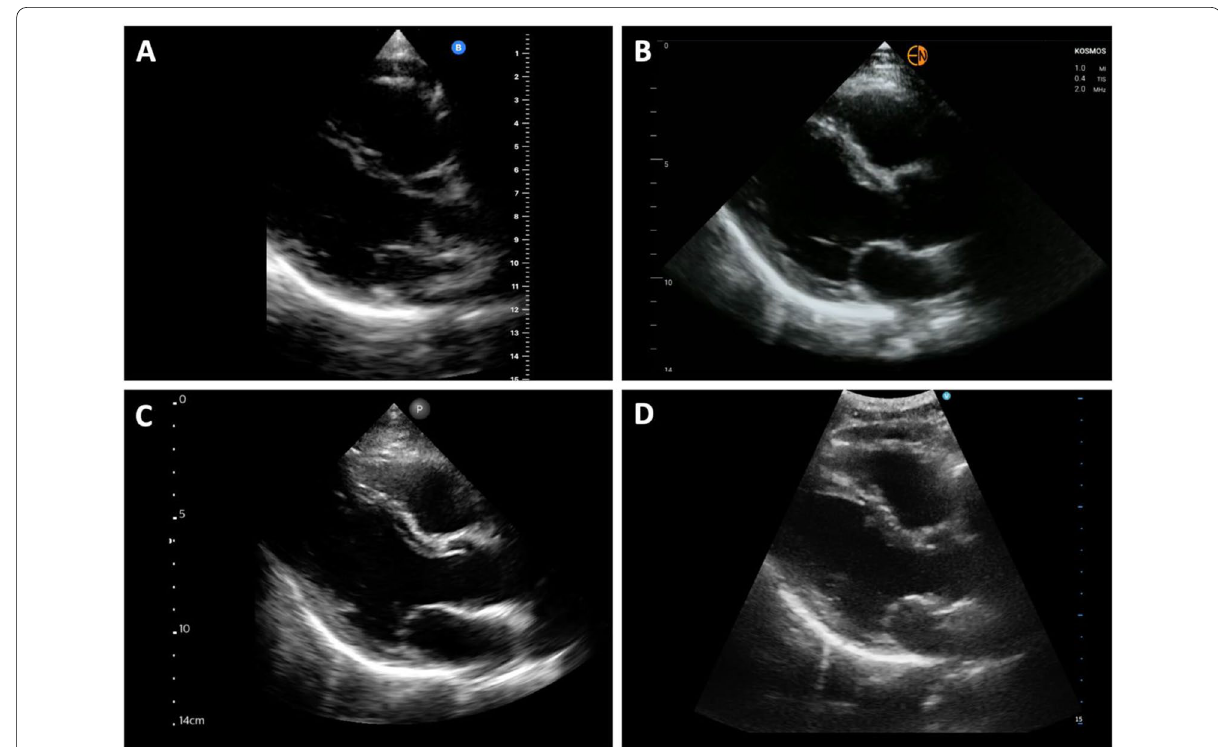
Fig. 2 Parasternal long‑axis view by four handheld ultrasound devices. Parasternal long‑axis views acquired from the same standardized patient in early systole with the mitral valve closed and aortic valve open are shown from the A Butterfly IQ (Echonous, Inc.), C Lumify ™ (Phillips Healthcare), and D Vscan Air ™ (General